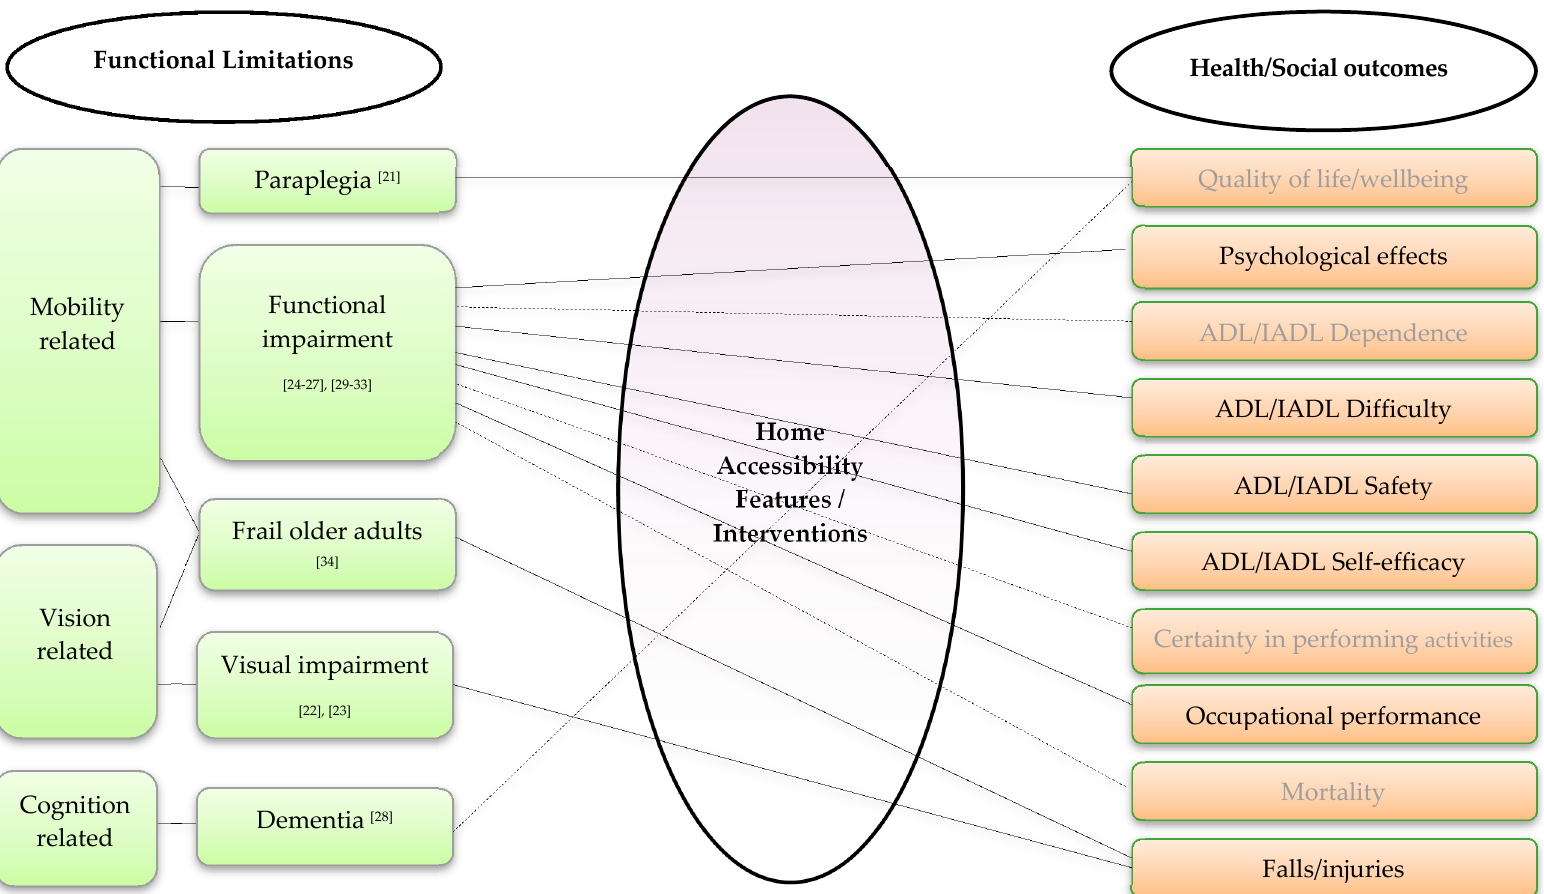
Figure 2. Associations between functional limitations, home accessibility features and outcomes (…. represents no significant or inconsistent associations/effects).